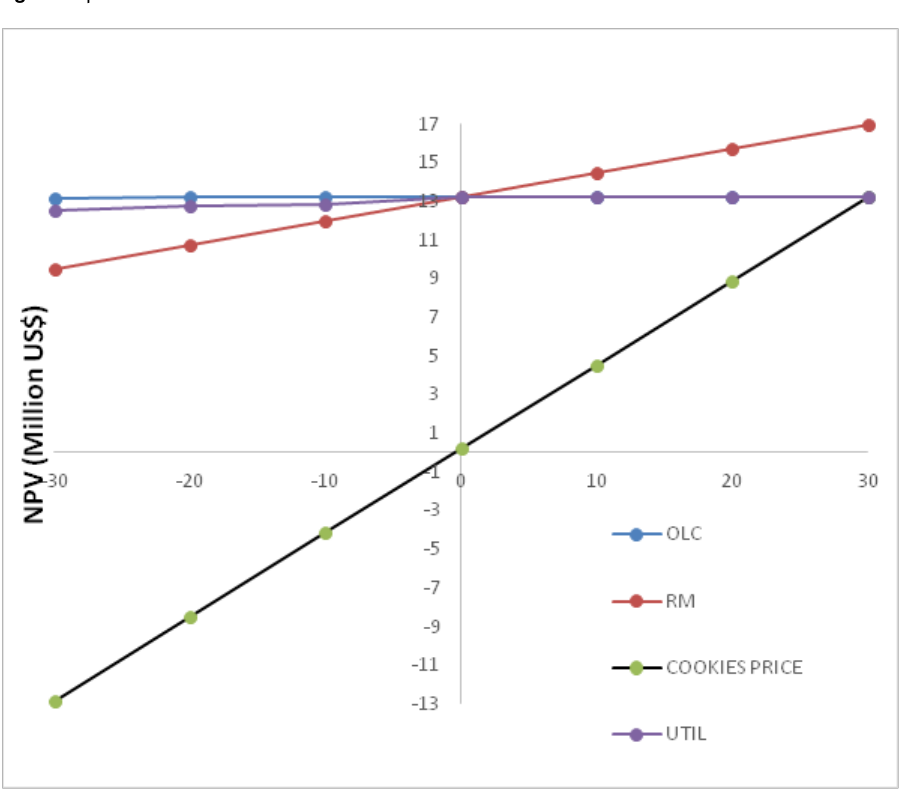
Fig 4. Net present value at different discount